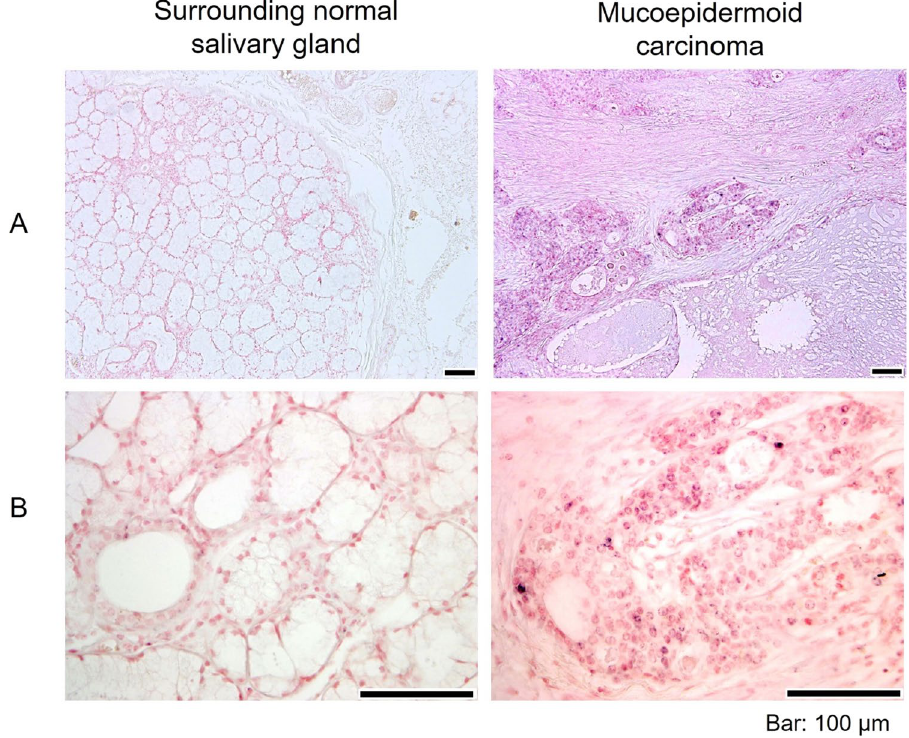
Figure 3. Comparison of the expression patterns of C2GnT-1 between MEC and its surrounding normal salivary gland. The representative images (original magnification, × 100 ( A ) and × 400 ( B )) of ISH of C2GnT-1 are shown. Scale bars indicate 100